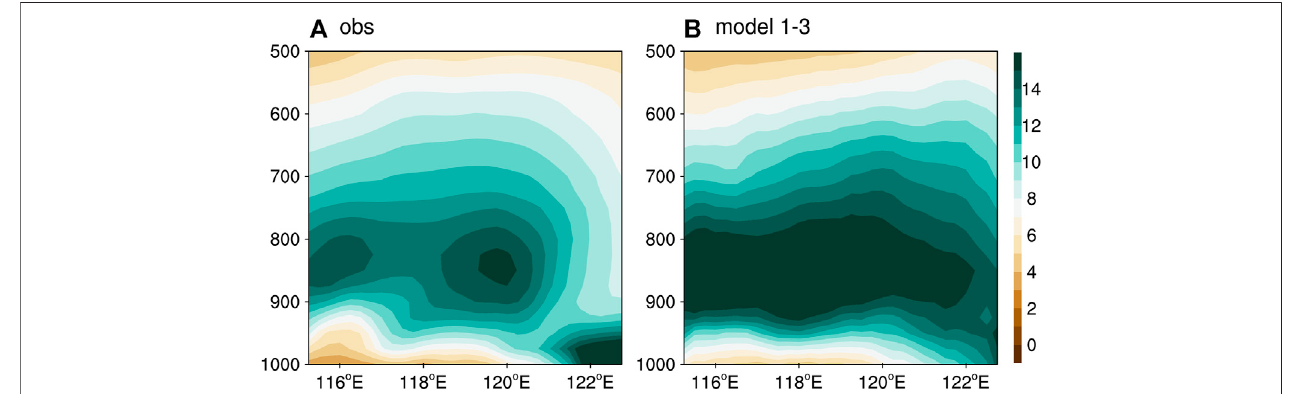
FIGURE 8 | Composites of the meridional-height section of longitude mean of water vapor fl ux ( g · cm − 1 · s − 1 · hPa − 1 ) along (31 ° N – 33 ° N) during WRWS occurrence moments for (A) observations and (B) the PWAFS forecasts.